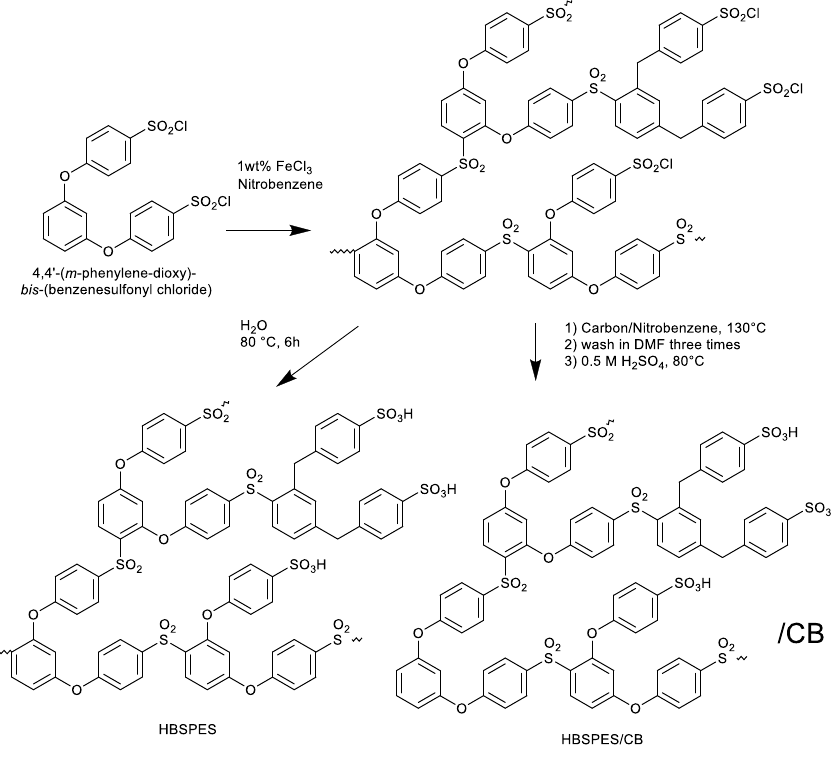
Scheme 1. Synthesis route of HBSPES and HBSPES/CB [10].